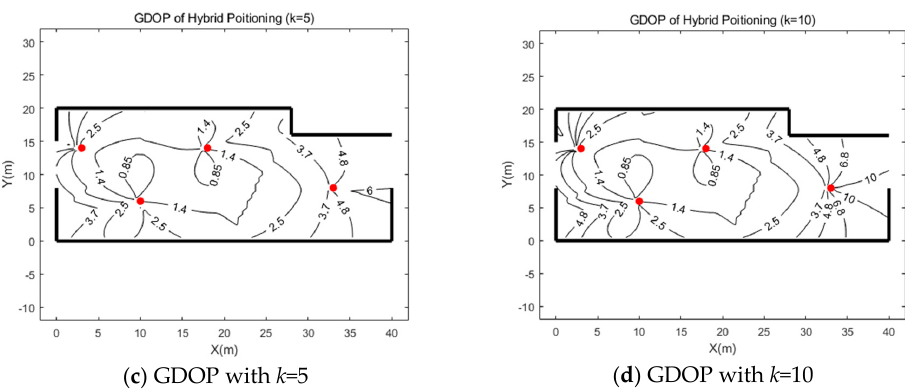
Figure 5. Geometric dilution of precision (GDOP) of the proposed hybrid time-difference-of-arrival (TDOA) and time-of-arrival (TOA) positioning in the developed indoor simulation scenario. The red dots are ANTs.